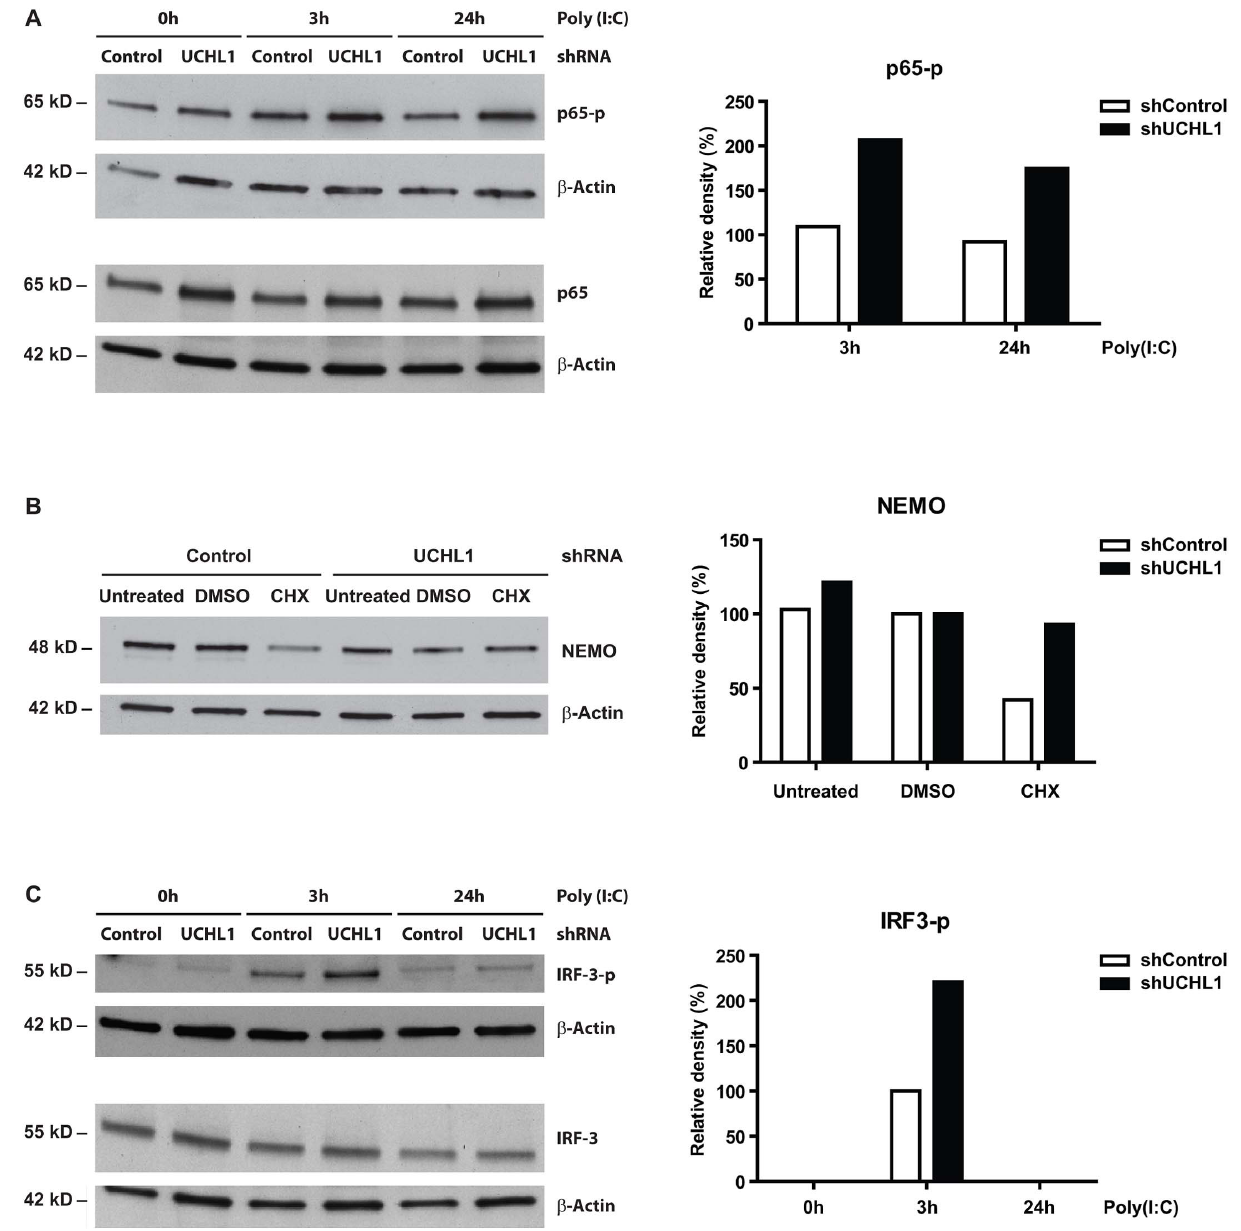
Figure 6. UCHL1 reduces phosphorylation levels of IRF3 and p65 and degrades NEMO in hrHPV-positive KC. ( A ) UCHL1 knock down effect on poly(I:C) stimulated p65 phosphorylation in HPV16 + keratinocytes. Monolayer cultures of shControl or shUCHL1-expressing HPV16 + KCs were stimulated for 0, 3 or 24 hours with Poly(I:C). Whole cell extracts were analyzed by western blotting for p65, p65-p and b -Actin (as loading control). The relative expression of p65-p was quantified by measuring its density and by normalizing it to that of b -Actin. The expression levels of p65-p in the 0 h Poly(I:C) cells were set to 100% for both shControl and shUCHL1 cells. The p65-p levels in the 3 h and 24 h Poly(I:C) cells were calculated against the levels measured at 0 h Poly(I:C) (right panel). ( B ) NEMO protein levels after knock down of UCHL1 in HPV16 + KCs. Monolayer cultures of shControl or shUCHL1-expressing HPV16 + KCs were treated with 100 m M cycloheximide (CHX) for 16 hours. Whole cell extracts were analyzed by western blot using antibodies against NEMO and b -Actin (control for protein content). The relative expression of NEMO was quantified by measuring its density and by normalizing it to that of b -Actin. The expression of NEMO in the DMSO control was set to 100% (right panel). ( C ) UCHL1 knock down effect on poly(I:C) stimulated IRF3 phosphorylation in HPV16 + keratinocytes. Similar to A, however cell extracts were analyzed by western blotting using antibodies against IRF3, IRF3-p and b -Actin (as loading control). The relative expression of IRF3-p was quantified by measuring its density and by normalizing it to that of b -Actin. The expression of IRF3-p in the 3 h Poly(I:C) control cells (no knock down of UCHL1 ) was set to 100% (right panel). doi:10.1371/journal.ppat.1003384.g006 clearly affected proinflammatory cytokine synthesis (Figure 5) the cells showed that UCHL1 bound to TRAF6 but not to NEMO interaction of UCHL1 with TRAF6 and NEMO was tested. Co- (Figure 7A). In contrast to what we observed for TRAF3, UCHL1 expression and immunoprecipitation experiments in HEK293T displayed a modest effect on the poly-ubiquitination of TRAF6